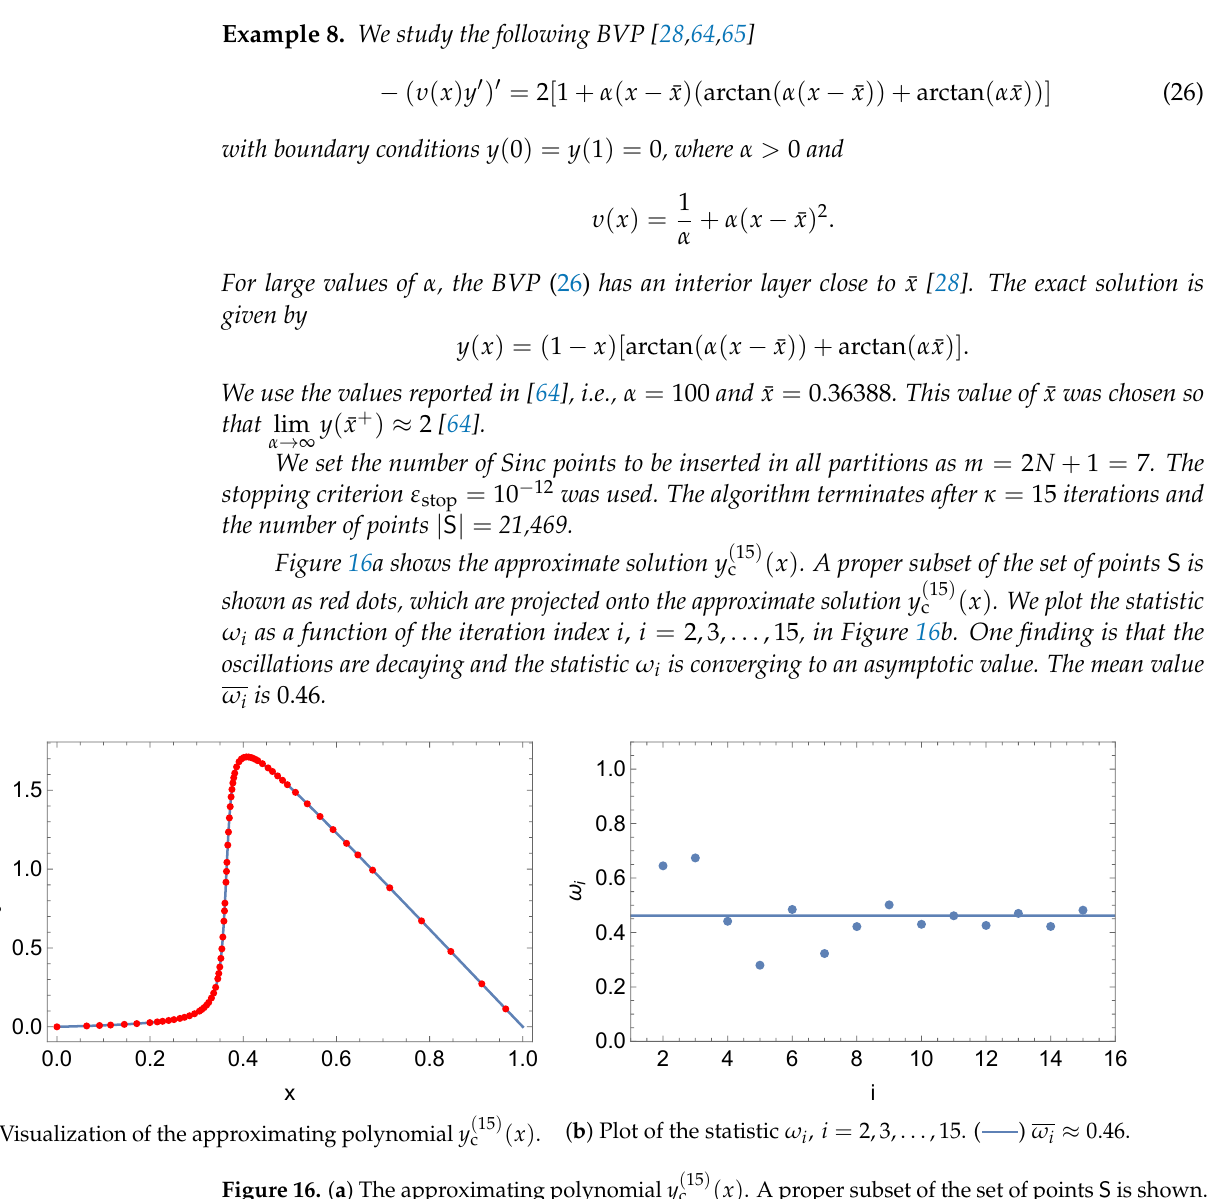
Figure 15. Plotting the set R for m = 2 N + 1 = 5 Sinc points ( ) and m = 2 N + 1 = 7 Sinc points ( ).